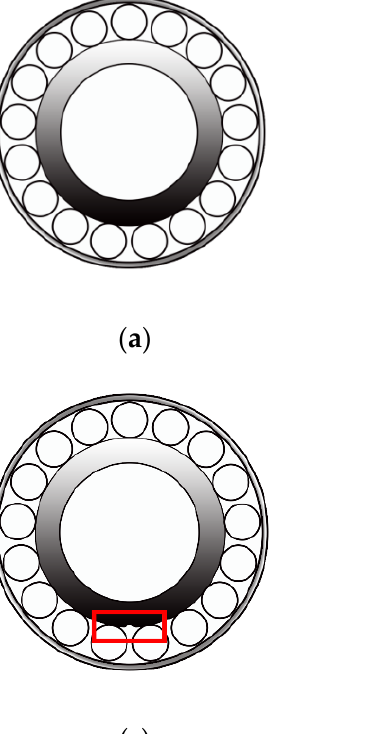
( d ) Figure 4. Fault characteristic frequency of axle box bearing at different speeds: ( a ) time domain di- agram of outer ring fault characteristic frequency of 24.3 Hz; ( b ) time domain diagram of outer ring fault characteristic frequency of 255.5 Hz; ( c ) envelope spectrum of outer ring fault characteristic frequency of 24.3 Hz; ( d ) envelope spectrum of outer ring fault characteristic frequency of 255.5 Hz.